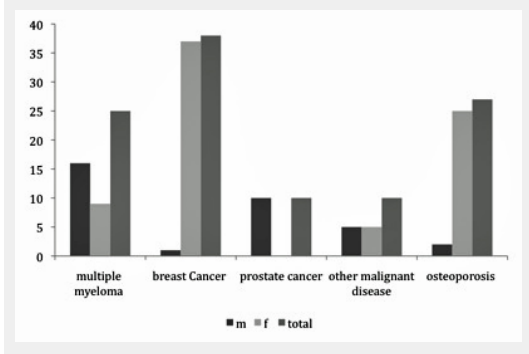
Display of underlying malignant disease and gender distribution of all patients (m = male; f = female).